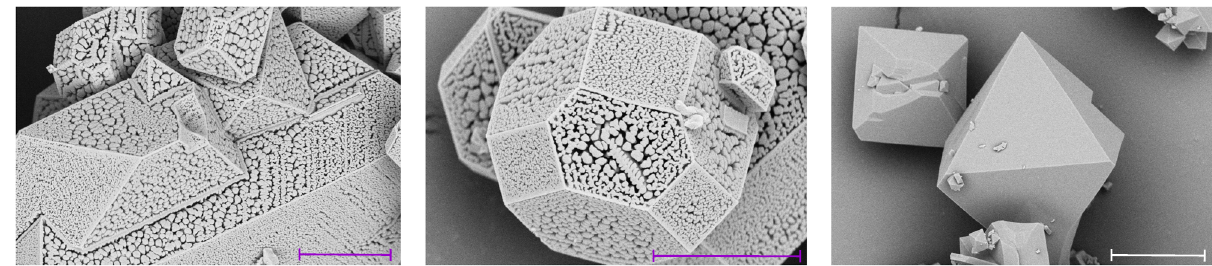
Fig. 2 Scanning electron micrograph of several Cu-HKUST-1 samples. All these samples have high crystallinity (See Supplementary Note 10) but show a wide range of surface areas (see Table 1 for surface areas and Supplementary Figure 11 for more images). Scale bars for sample 1, sample 3 and